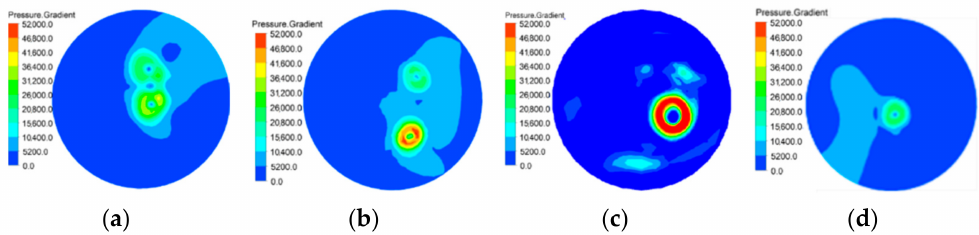
Figure 13. Pressure gradient distribution in the vortex area at different moments. ( a ) t 0 = 1.03 s, ( b ) t 1 = 1.33 s, ( c ) t 2 = 1.63 s, and ( d ) t 3 = 1.9.